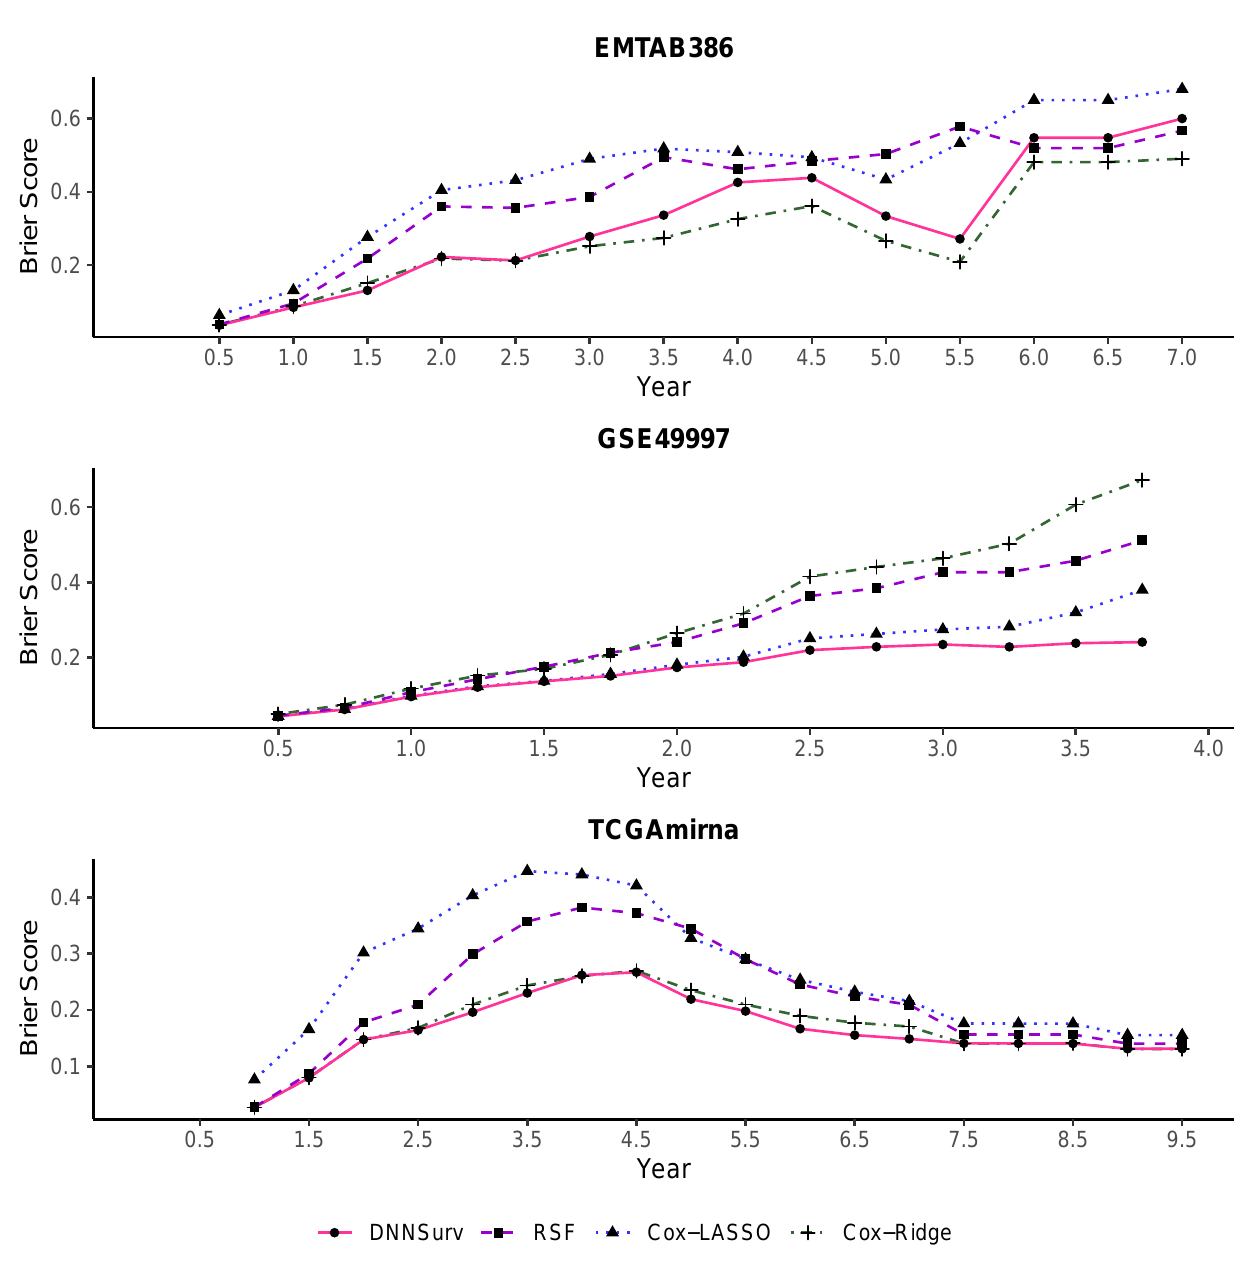
Figure 7. The time-dependent Brier score for all four models on three test datasets that contain both gene and clinical variables (G +